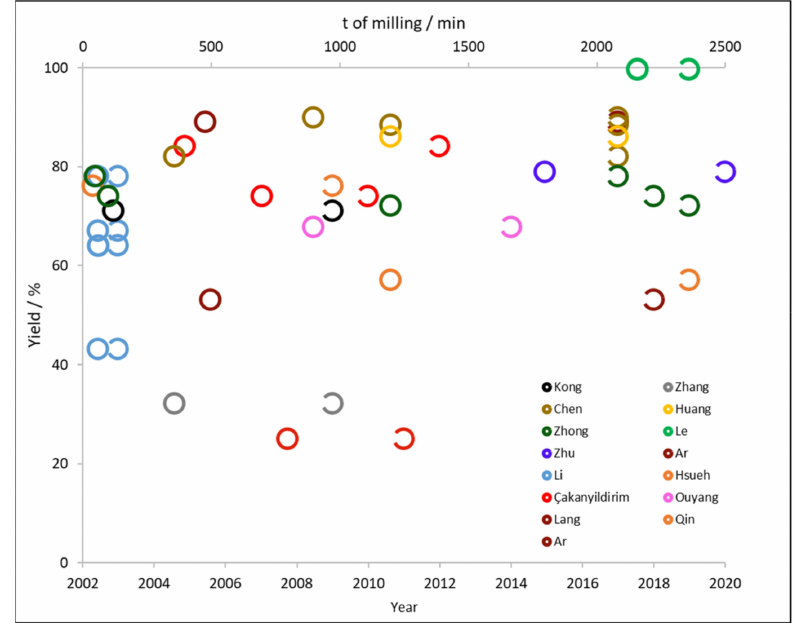
Figure 5. Reported yields for NaBH 4 regeneration through mechano-chemical